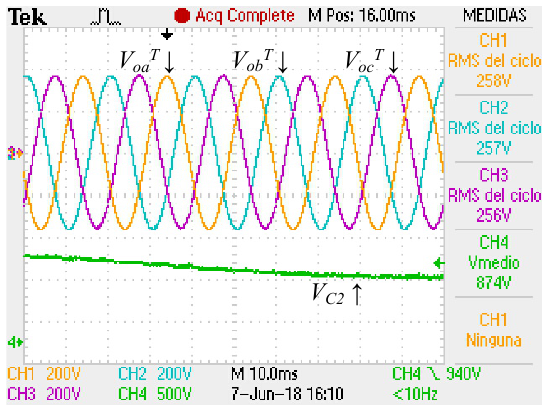
Figure 17. PCC o voltages and V C 2